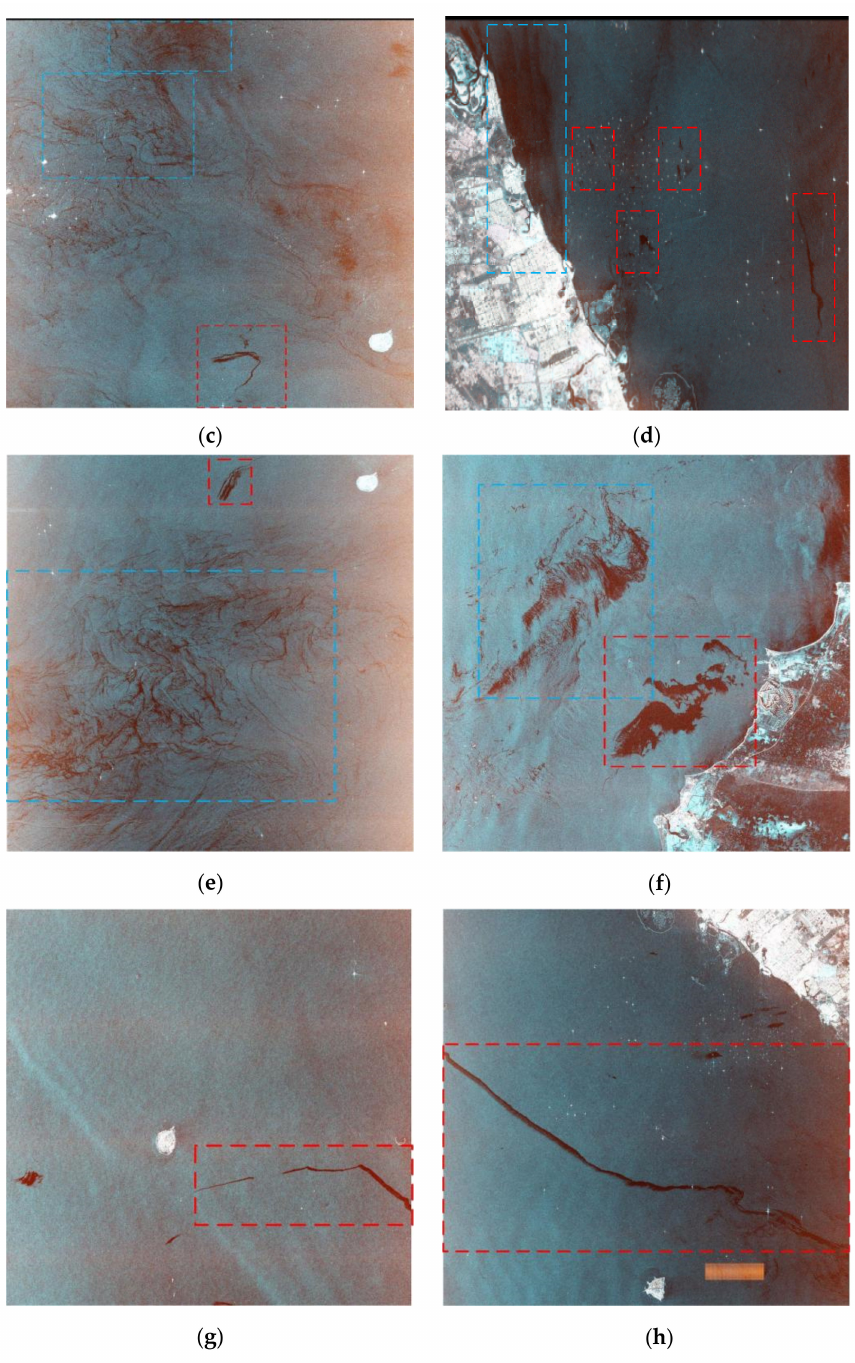
Figure 6. Pseudo-color images. The dark spots within red dotted boxes represent oil spill area, while blue dotted boxes represent look-alike areas: ( a ) Image 1, ( b ) Image 2, ( c ) Image 3, ( d ) Image 4,